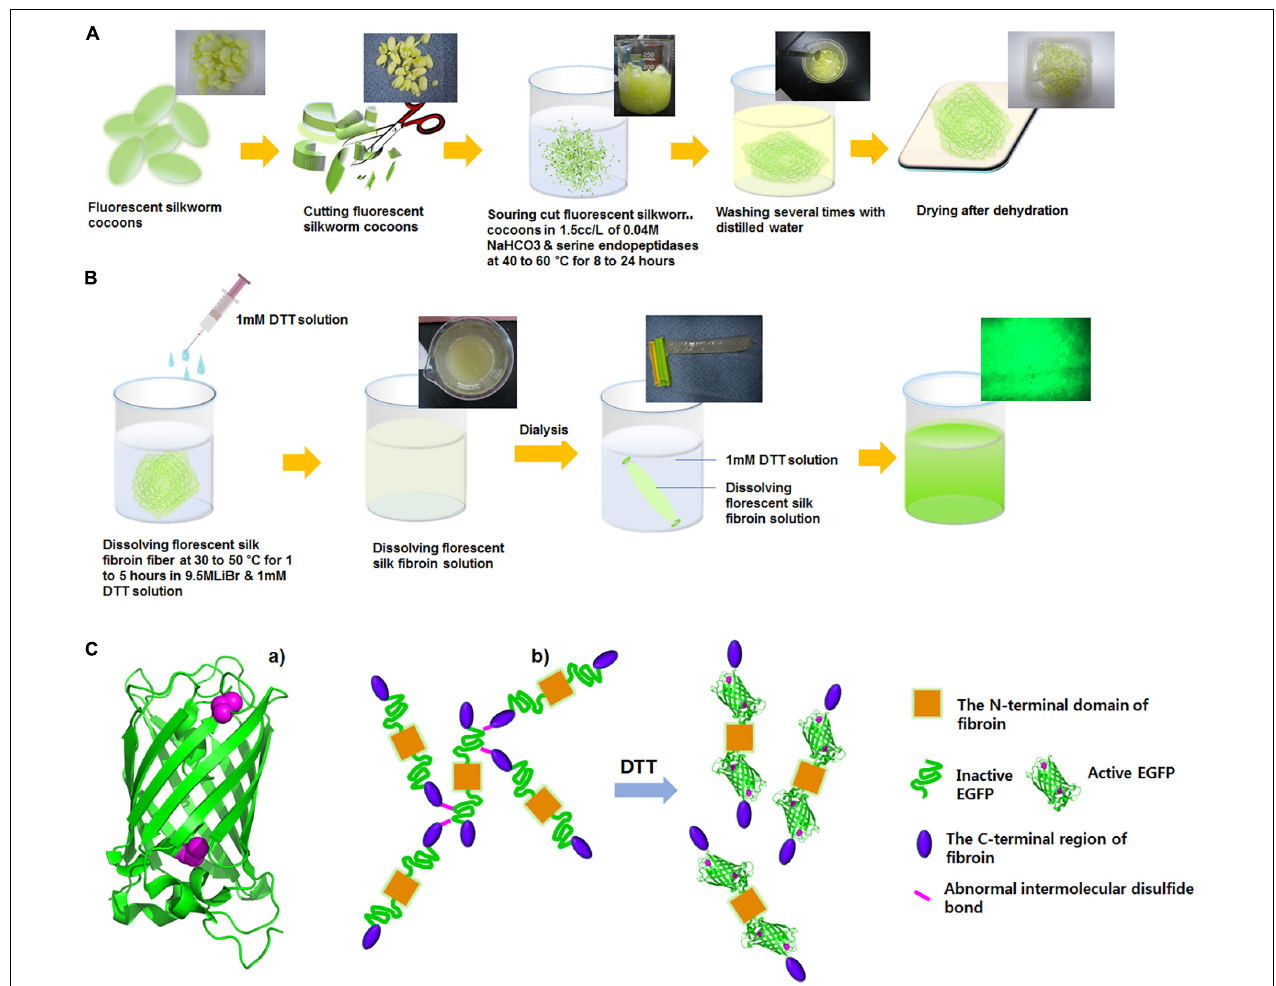
FIGURE 2 | Preparation of fluorescent silk fibroin solution. (A) Fluorescent silk was degummed with 0.5% (w/w) Na 2 CO 3 with 1 mM DTT solution at 45 ◦ C for overnight and then washed with distilled water. (B) Degummed fluorescent SF was dissolved in 9.5 M LiBr for 4 h at 45 ◦ C and dialyzed to remove salts in a cellulose tube against distilled water for 2 days at room temperature. (C) The critical role of DTT in the improvement of fluorescent activity of the fluorescent fibroin. (a) The EGFP structure (green ribbons) with two cysteine residues (magenta spheres). EGFP, EYFP, and mKate2 contain cysteine residues that are not involved in disulfide bonds. (b) A model for the improvement of fluorescence activity of the fluorescent fibroin in the presence of DTT. DTT would allow EGFP to be properly folded and to exert fluorescent activity by preventing the formation of abnormal intermolecular disulfide bonds. Reproduced from Kim et al. (2015) with permission from